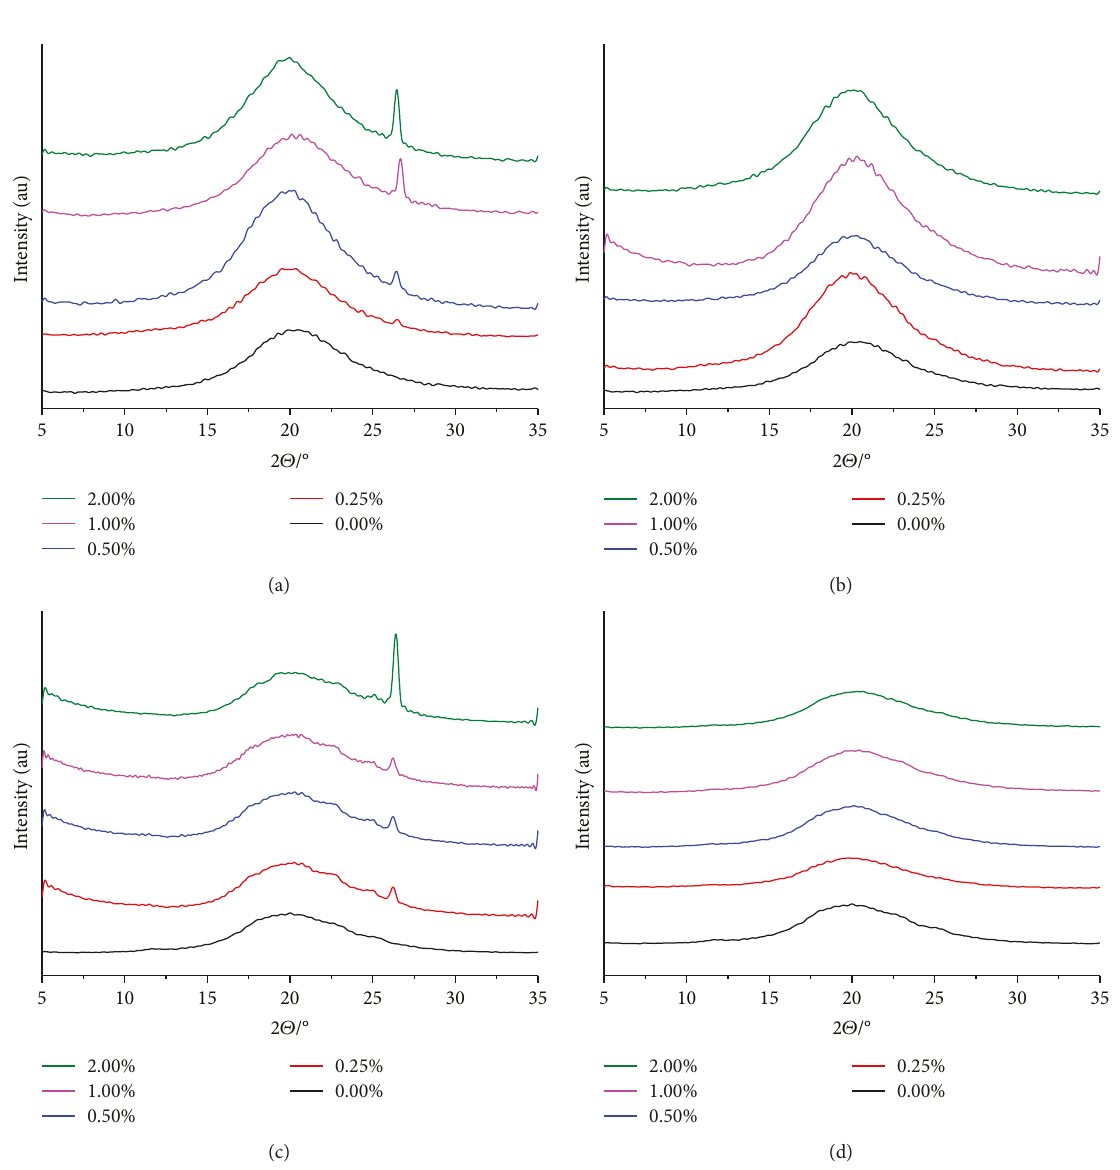
Figure 9: XRD for (a) PU20-GNP, (b) PU20-RGO, (c) PU40-GNP, and (d) PU40-RGO